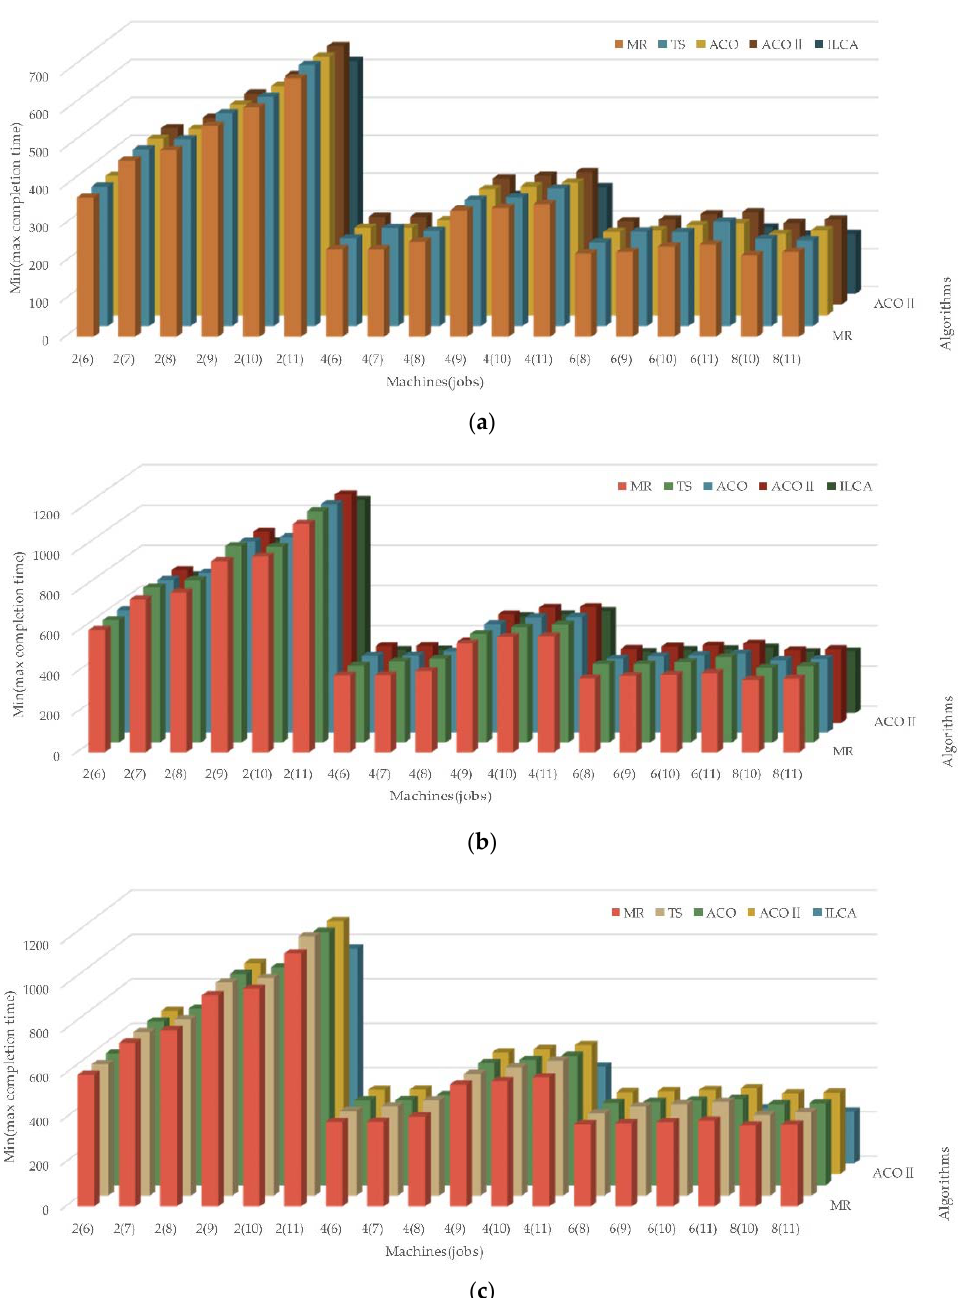
Figure 4. The comparison of solutions. ( a ) represents the maximum completion time obtained by using different algorithms for different benchmark cases in the case of Balanced; ( b ) represents the case of Processing; similarly ( c ) represents the case of